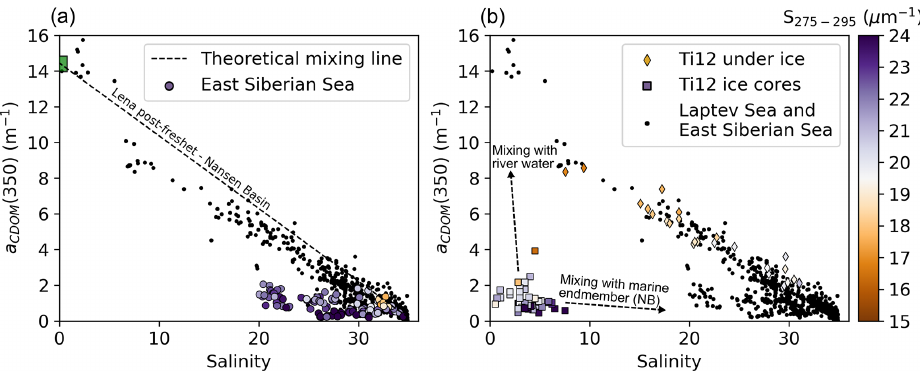
Figure 5. (a) Salinity and a CDOM (350) in the ESS (August and September 2019, coloured dots) and LS (black dots). The broken line shows the theoretical conservative mixing line between the Lena River water that enters the LS after the spring freshet (post-freshet) and the marine endmember (Nansen Basin seawater, NB). The colour of the dots shows the slope of the absorption spectra in the range between 275 and 295nm ( S 275 − 295 ). (b) Salinity, a CDOM (350) and S 275 − 295 in land-fast ice (squares) and sub-ice water samples (diamonds) in the LS collected in (March/April 2012). The arrows indicate the direction of theoretical conservative mixing lines between the land-fast-ice meltwater and the Lena River water, as well as between the meltwater and the marine endmember. The black dots represent the samples from the LS and ESS